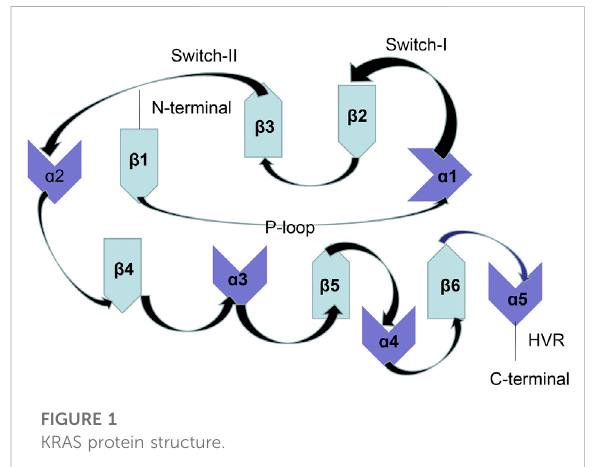
FIGURE 1 KRAS protein structure.